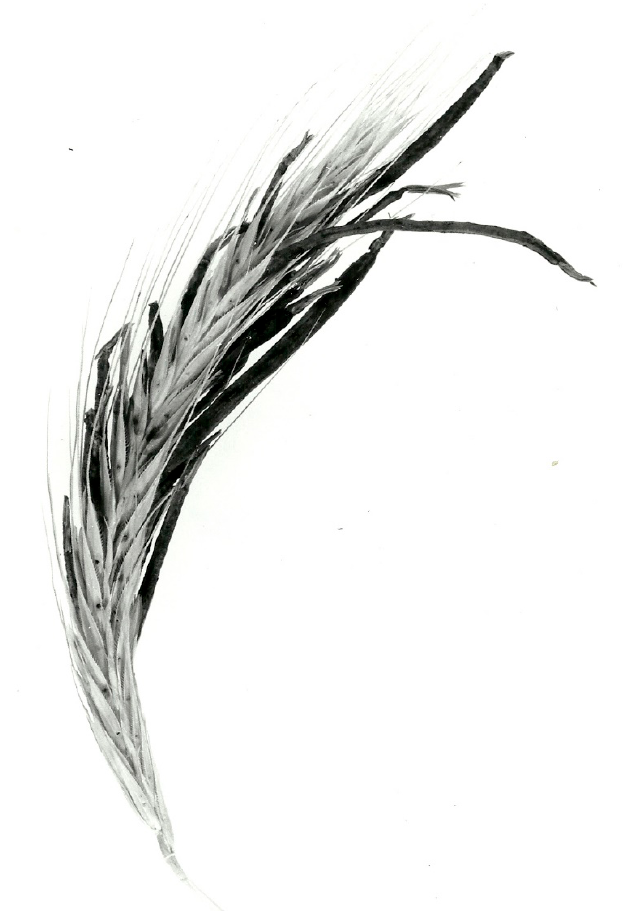
Figure 3. Fourex rye ear bearing sclerotia of C. purpurea isolated from ergots on A. myosuroides . Glasshouse grown plant inoculated before anthesis; hypodermic needle lesions are on glumes. Circumstances of infected anther filament (and anther) inclusion within developing sphacelium ensured retention of anthers at sclerotial tips.